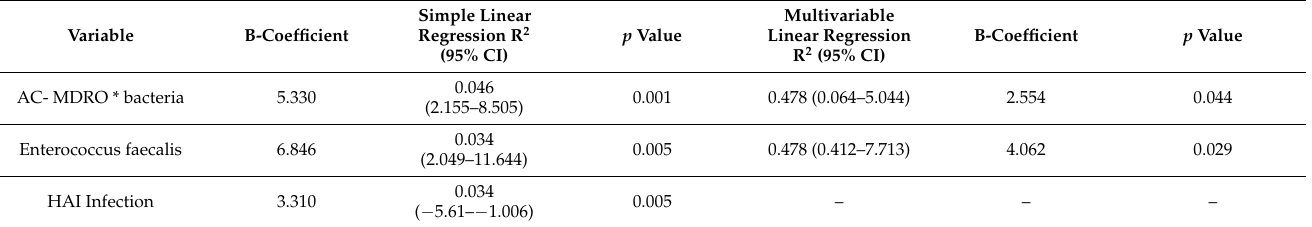
Table 5. The univariate and multivariate linear regression of MRDO organisms as predictors for increasing (ICU-LOS).